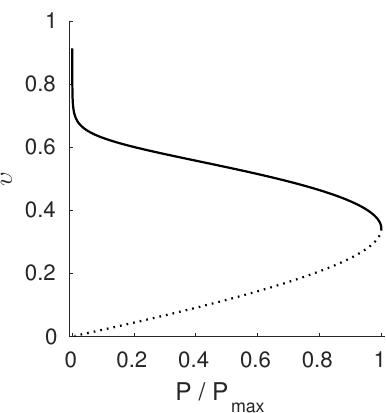
Figure 1. Polarisation curve (blue) and power curve (red) of a plymer electrolyte membrane fuel cell. Dotted line marks the high current branch above the maximum power point.